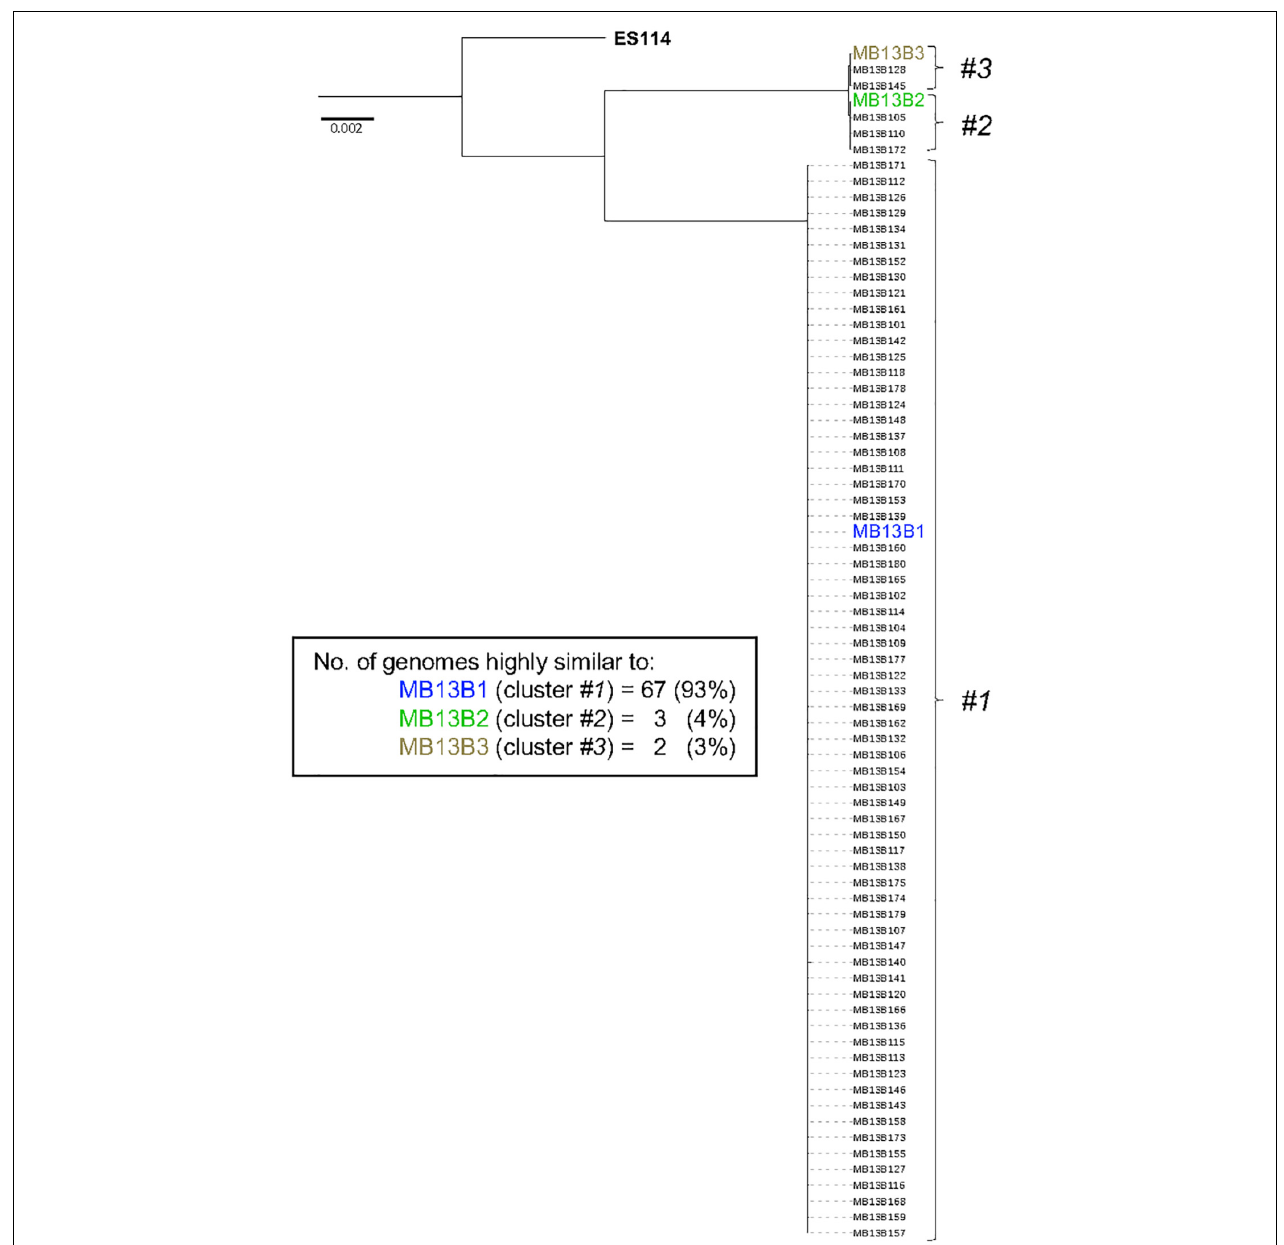
FIGURE 4 | Phylogenetic tree based on the core genome sequence of 72 V. fischeri isolates from one lobe of an adult E. scolopes light organ. The tree is rooted using V. fischeri strain ES114; the locations of the 3 previously sequenced strains (colored) are